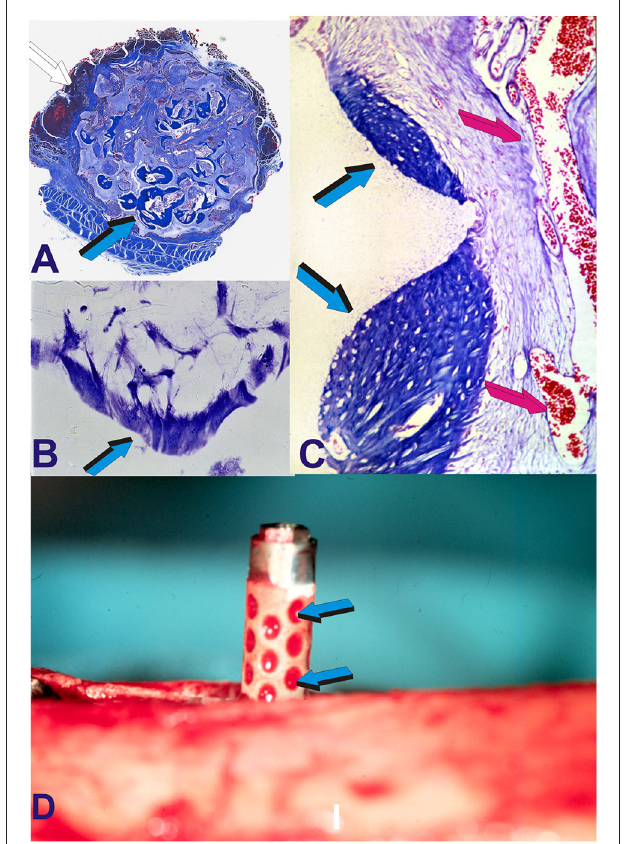
FIGURE 5 | Scanning electron microphotographs (SEM) of the geometrical configuration of the concavity assembled into the titanium bioreactors. (A,B) Macro- and microporous geometric landscapes of titania substrata later coated by highly sintered crystalline hydroxyapatite. Macro- and micro-topography of the constructed concavities (light blue arrows) within the titanium’ bioreactors present surface topographies that result I the induction of bone differentiation in vivo (Ripamonti et al., 2012a, 2013). (C) A concavity (light blue arrows) prepared on the titanium’ surface show nano-topographic macro- micro-porosities that are inductive of cell differentiation and the expression of the osteogenic phenotype (Ripamonti et al., 2012a,